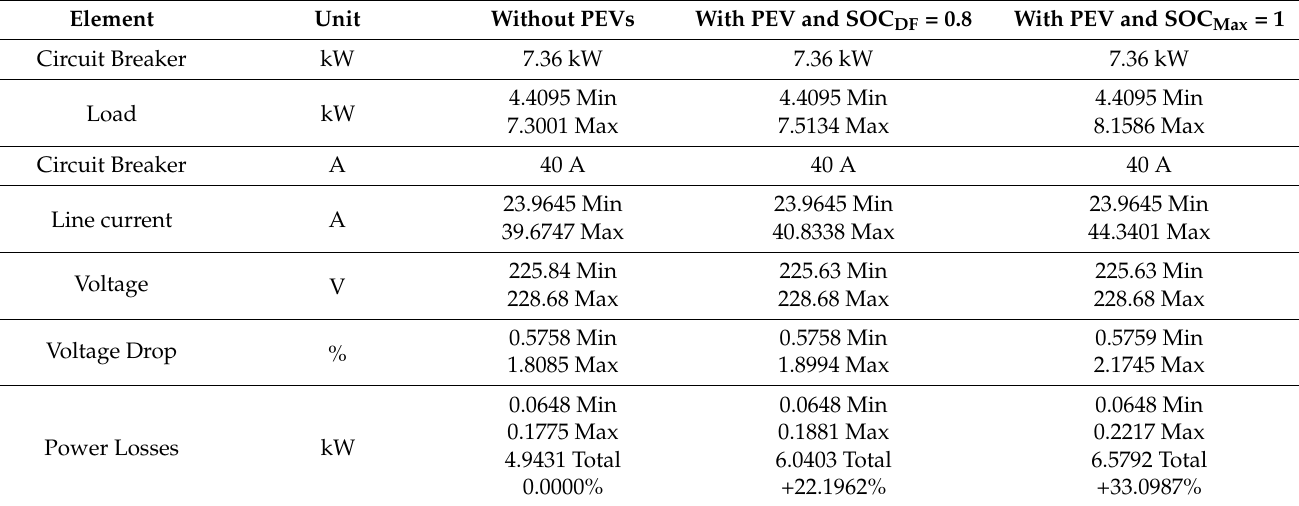
Table 7. Power demand and loss, current and voltage at home (dynamic price).